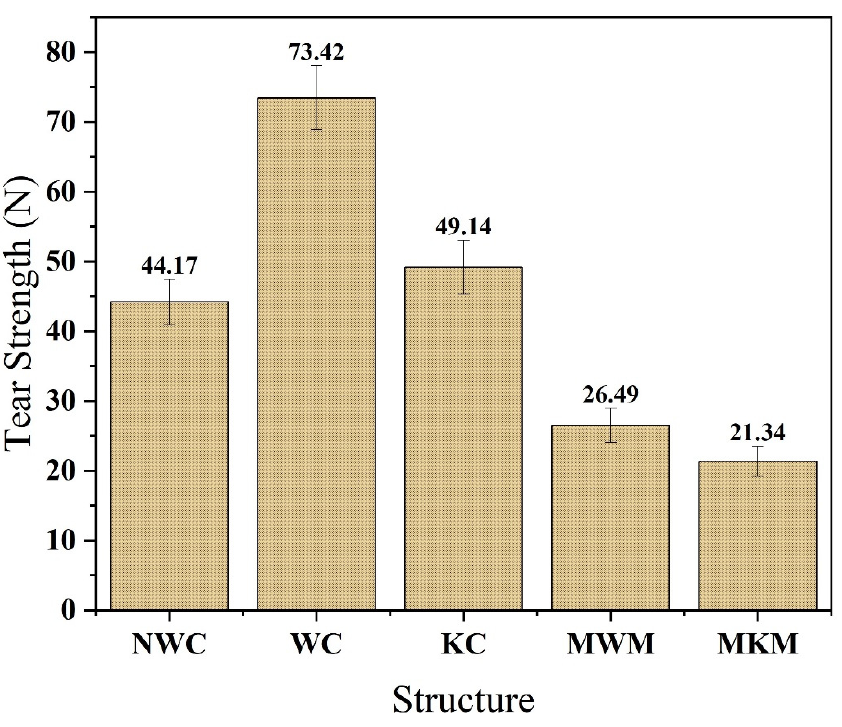
Figure 11. Tear strength of developed nanofiber membrane/textile composites and market-bought samples.